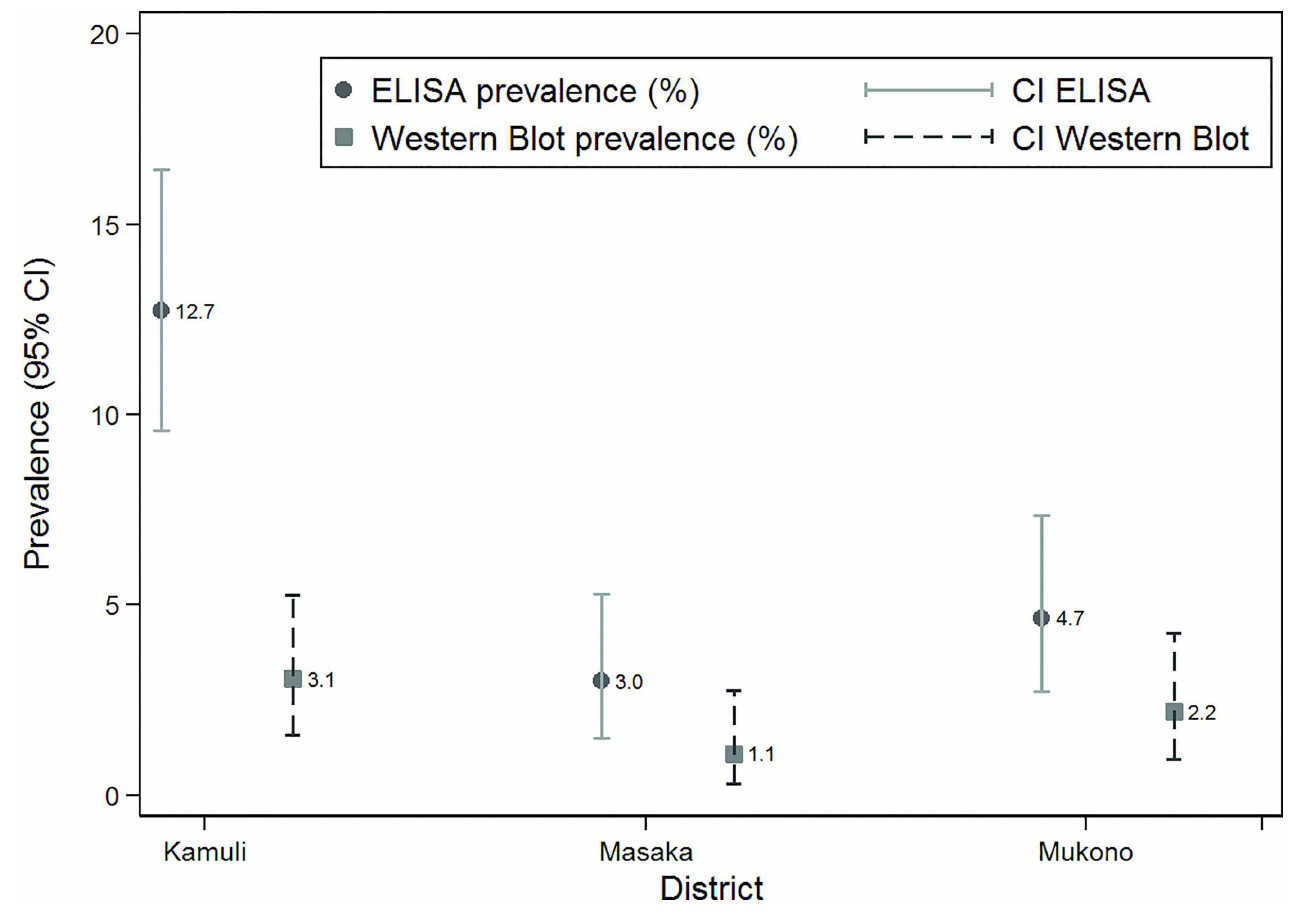
Fig 4. Proportion of ELISA positive samples confirmed by Western Blot based on somatic antigen of Trichinella spiralis in three districts in Central and Eastern Uganda, sampled between April and July 2013.